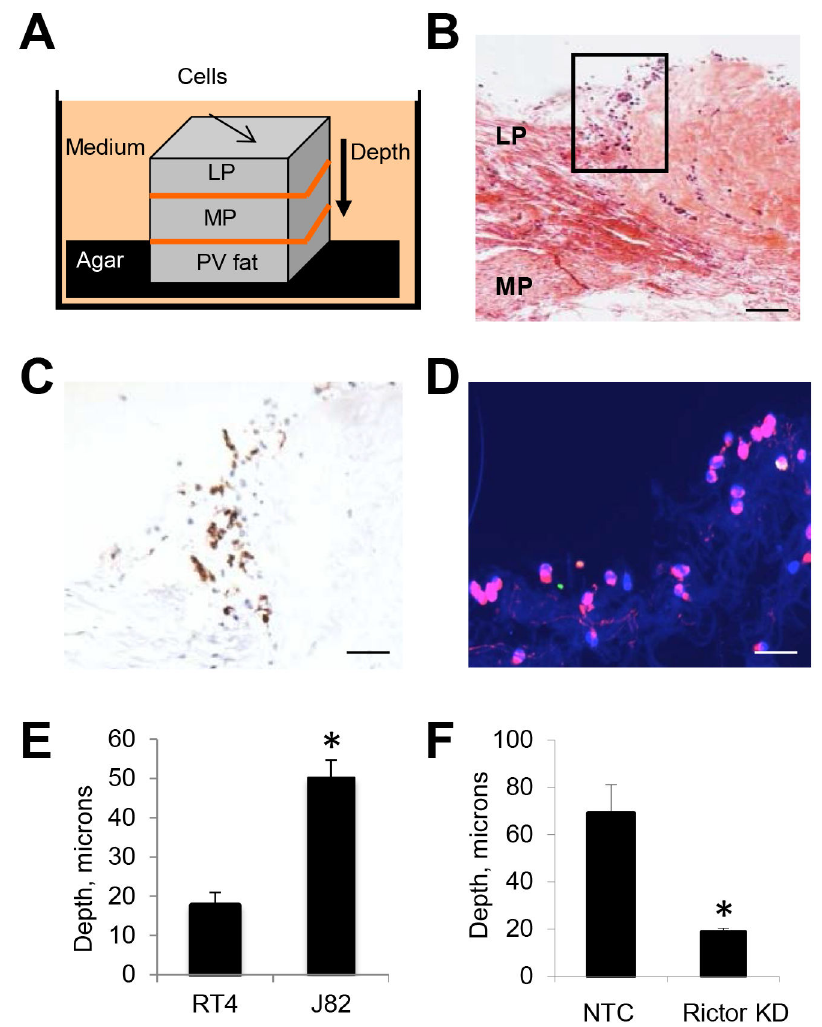
Figure 5. mTORC2 regulates invasion of bladder cancer cells into the human bladder wall. A , schematic showing orientation of human bladder wall invasion assay that includes lamina propria (LP), muscularis propria (MP) and perivesical fat (PV fat). B, H&E section showing invading J82 cells in the lamina propria after 72 h (scale bar 200 microns) C , cells highlighted in previous panel showed positive immunostaining for pancytokeratin (scale bar 100 microns). D , immunofluorescent stain shows invasion of malignant J82 cells (red), at 72 hr (scale bar 50 microns). E , quantification of tissue invasion by RT4 and J82 cells (microns). F , rictor gene-silencing significantly inhibits invasion of bladder all by J82 cells. (*) statistically significant comparison using student t- test,